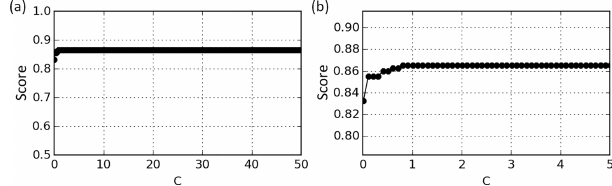
Figure 11. The classifier’s cross-validation accuracy as a function of C . (a) Overall evaluated range of C . (b) A closer look at values lower than